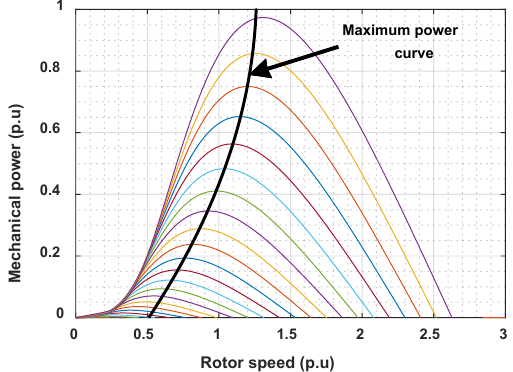
Figure 4. MPPT by curve fitting.